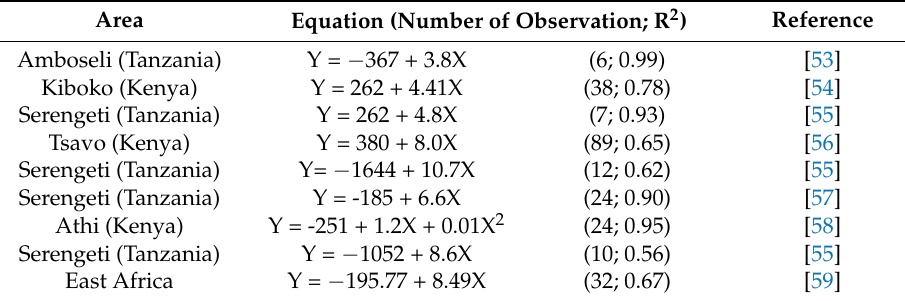
Table 1. Rainfall dependent forage production